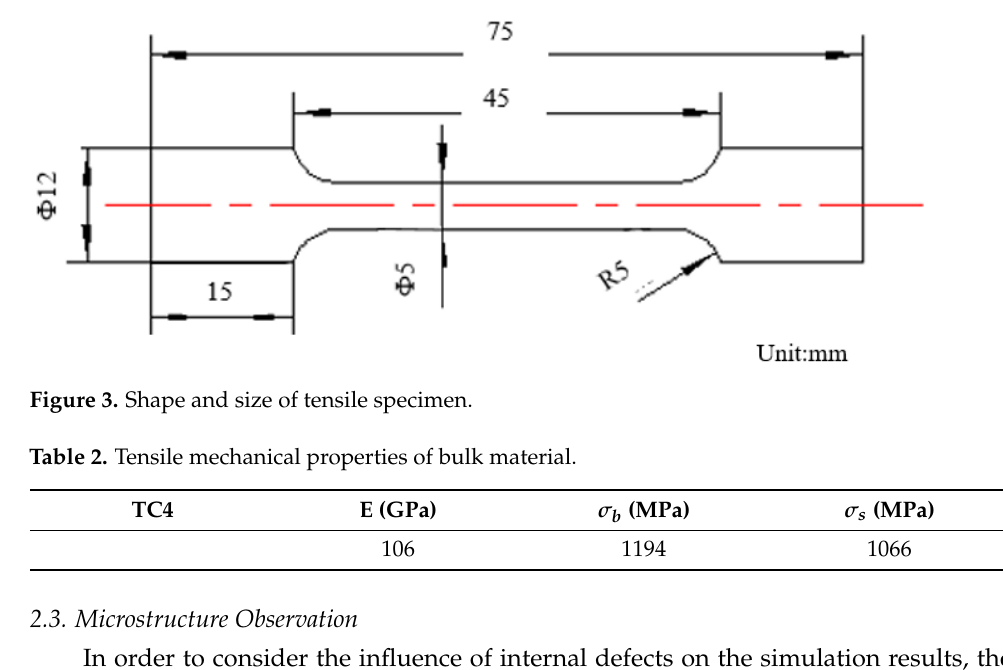
Figure 2. Compression stress–strain curve of the D structure.